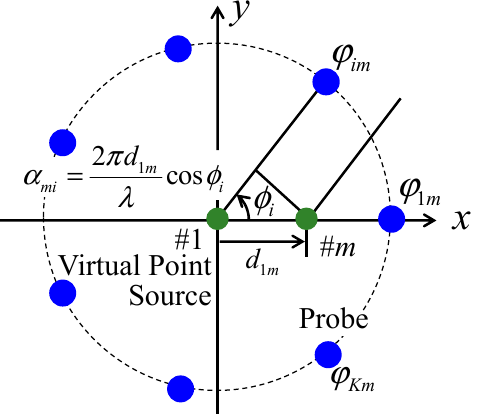
Figure 3. Implementation model for BS correlation.